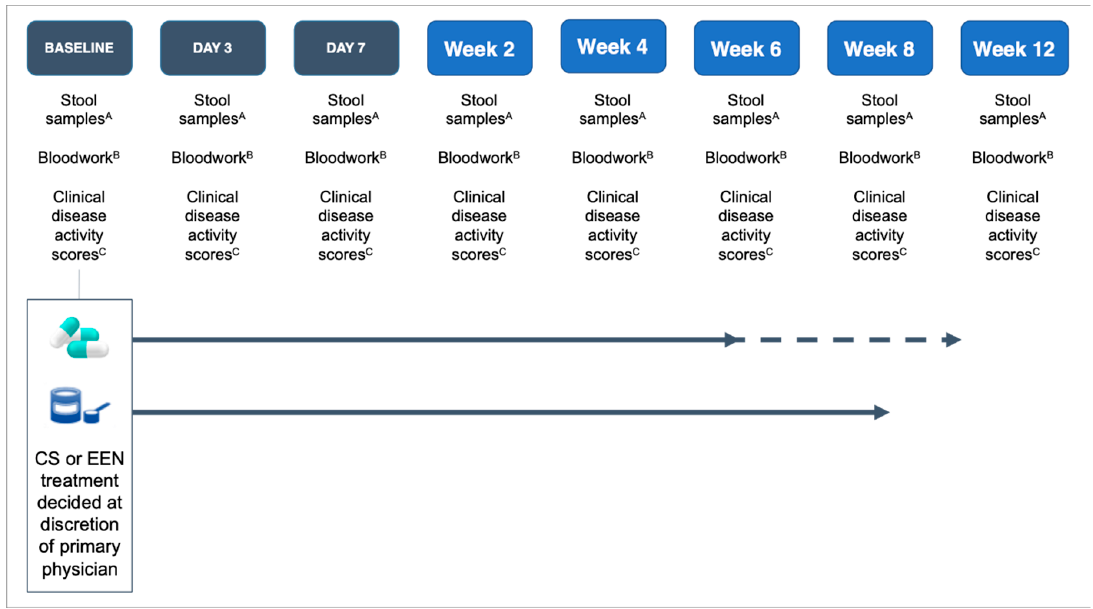
Figure 1. Overview of the study design. CS—corticosteroids, EEN—exclusive enteral nutrition. Note: